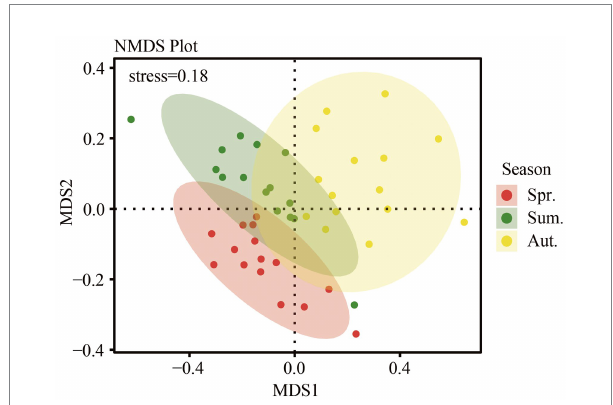
FIGURE 5 Fungal community structure based on Bray-Curtis distance, as determined by nonmetric multidimensional scaling (NMDS).